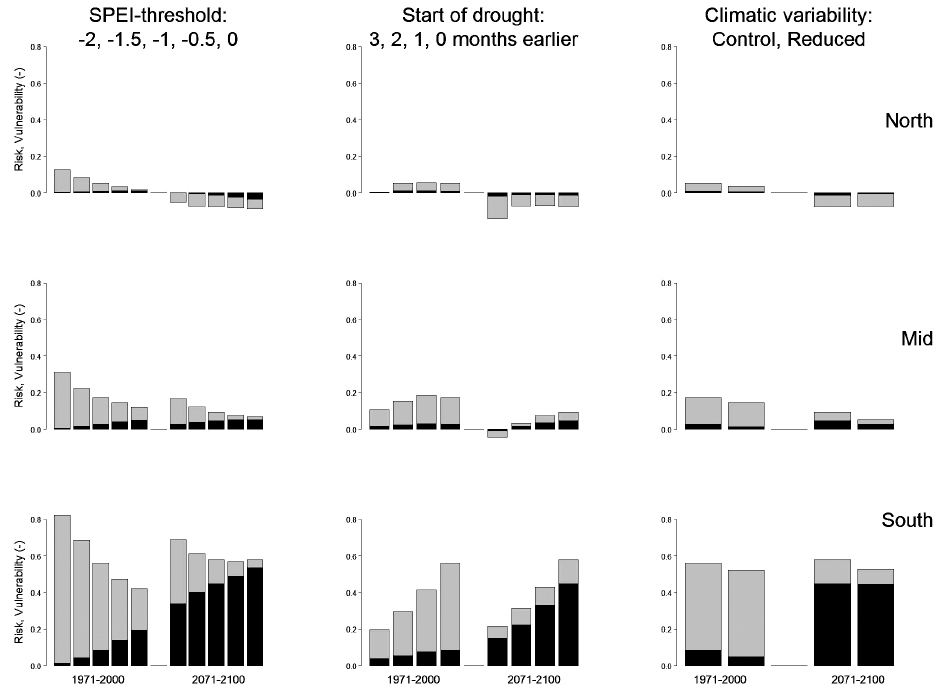
Figure 6. Sensitivity analysis of the probabilistic risk analysis (PRA) for NPP using the LPJmL model. The rows are for the three latitudinal bands shown in Fig. 3a. Left column: sensitivity of the PRA to the SPEI thresholds used to define drought. Middle column: sensitivity of the PRA to shifting the start of the six month period over which the SPEI is calculated. Right column: sensitivity of the PRA to reducing climatic variability. Whole bars represent vulnerability, the black shaded parts are the risks. Both are expressed in relative terms, as fractions of NPP under non-hazardous